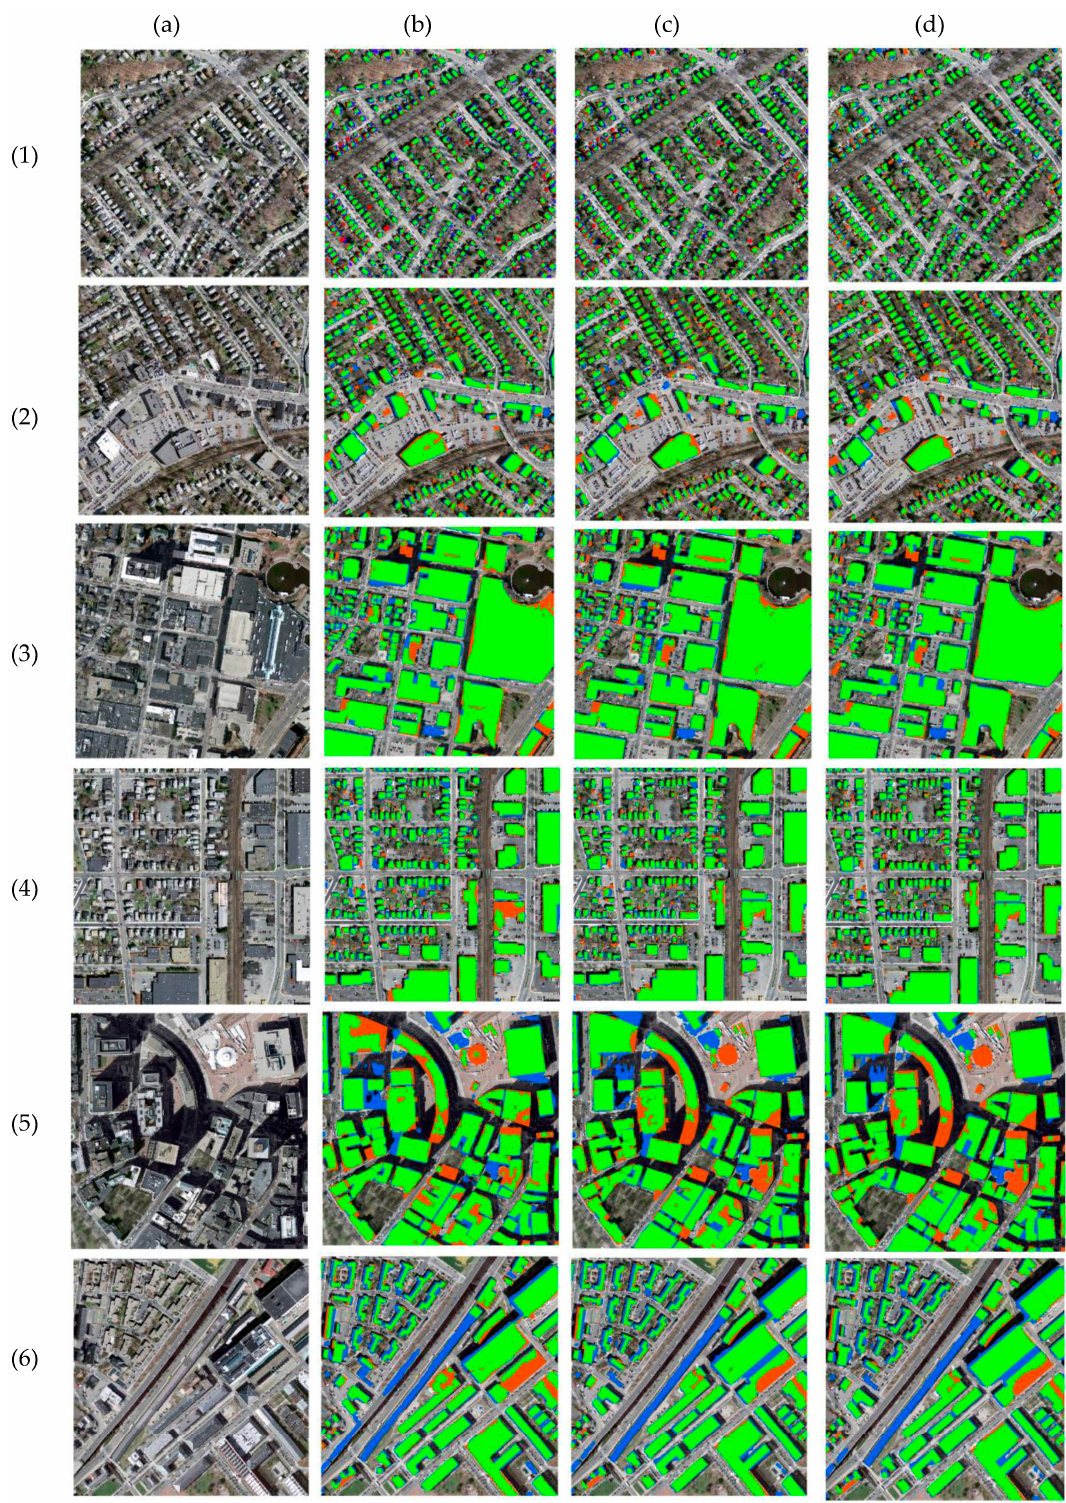
Figure 7 . Visualization of predictions of three variations of the proposed model on building detection tasks with original extracted test images from the Massachusetts dataset. ( a ) input images; ( b ) results of base FCN network; ( c ) results of ELU-FCN; and ( d ) results of ELU-FCN-CRFs. Green pixels are TP, red pixels are FN, blue pixels are FP, and background pixels are TN.